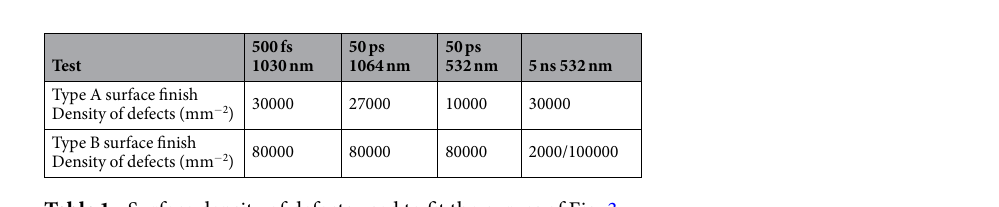
Table 1. Surface density of defects used to fit the curves of Fig.